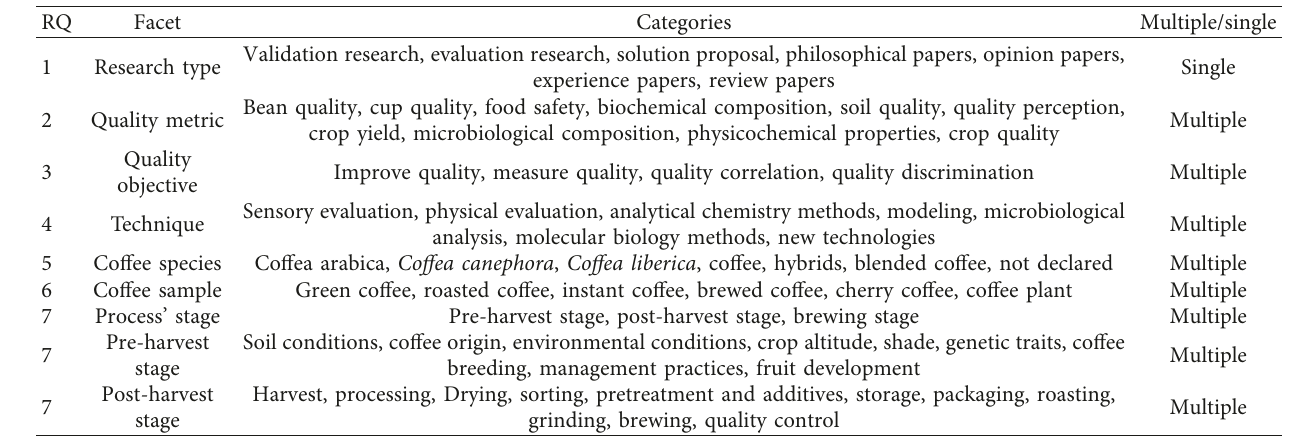
Table 3: Classification